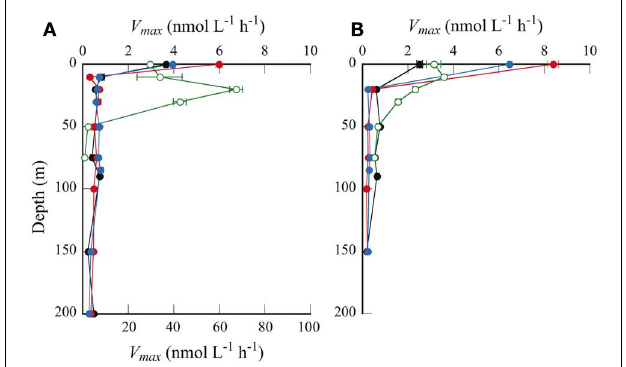
FIGURE 4 | Depth profiles of V max as determined by (A) the single-concentration method, and (B) the multiple-concentration method. Symbols are same as in Figure 2 . Note that in (A) , V max only for station H is plotted against the bottom axis with maximum value of 100nmolL − 1 h − 1